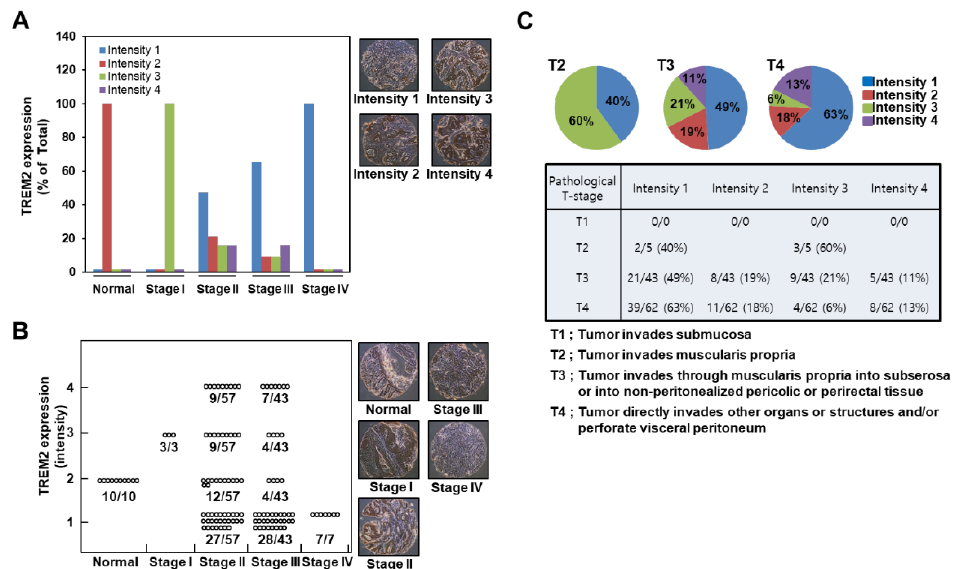
Figure 6. Downregulation of TREM2 expression in highly proliferative human colon carcinoma. ( A ) The expression levels of TREM2 in a human colon carcinoma tissue array were visualized by immunohistochemical analysis, ( B ) and the intensity was classified as grades of 1, 2, 3 and 4. The intensity of TREM2 was measured using the ImageJ computer program. ( C ) Protein expression levels of TREM2 according to the pathological T-stage of colon carcinoma tissues.